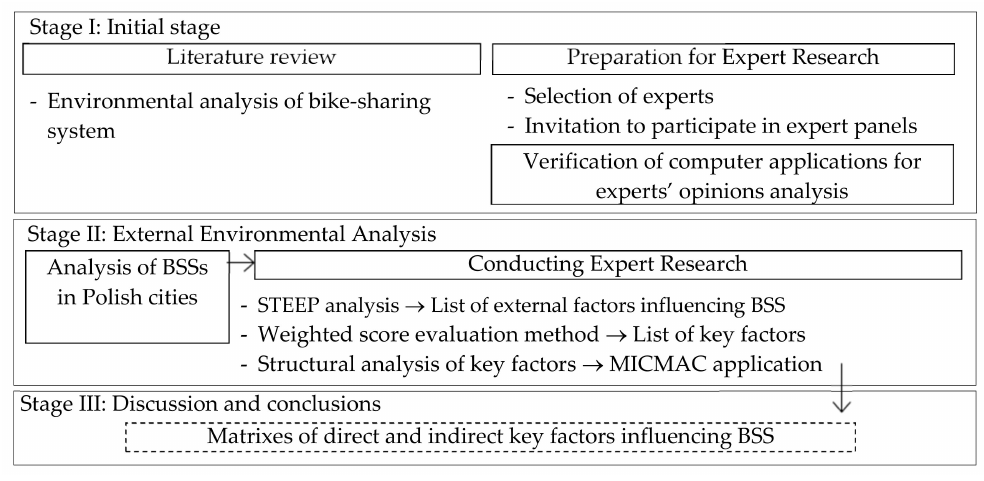
Figure 2. Research stages. Where: BSS—Bike-sharing system; STEEP—social, technological, eco- nomic, environmental, political factors; MICMAC—software name for structural